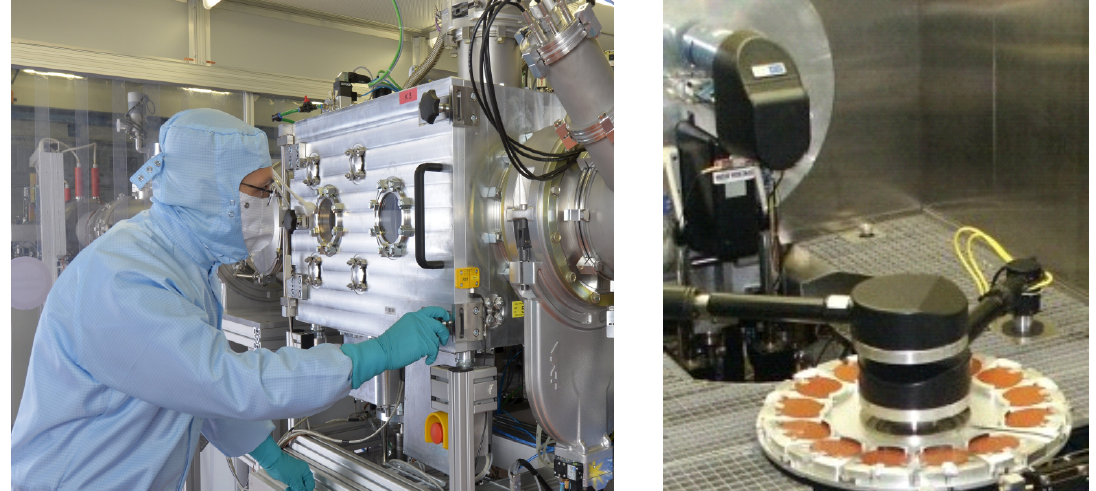
Figure 2: Implantation chamber (part of semi-automatic wafer handler system, ∅ 200 mm wafer capa- bility) at the 6 MV tandem (left), and wafer wheel (max. wafer size 150 mm) of the NV-10 end-station used for high-throughput implantations at the 3 MV tandem